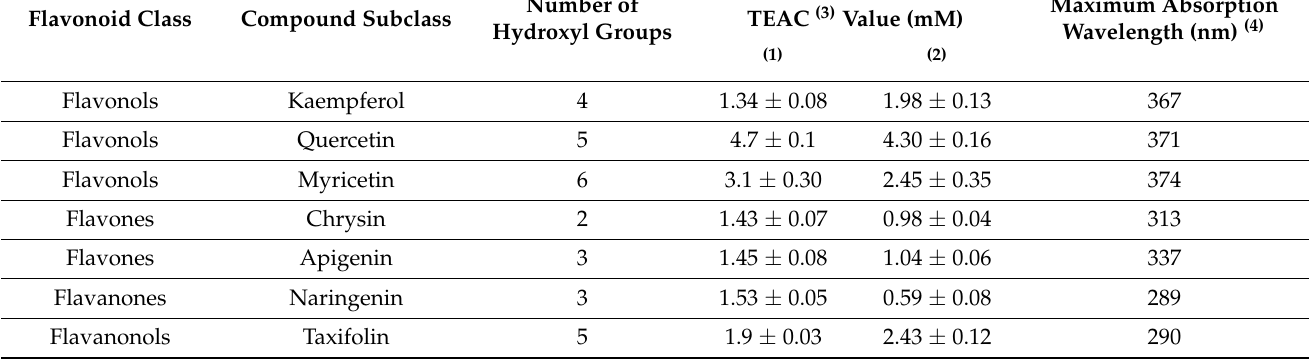
Table 1. Comparative physico-chemical properties of some of the main flavonols, flavones and flavanones. The higher the number of hydroxyl groups, the higher the antioxidant activity. An exception is made for quercetin for which the higher antioxidant activity is due to the ortho -dihydroxy structure in the B ring (see Figure